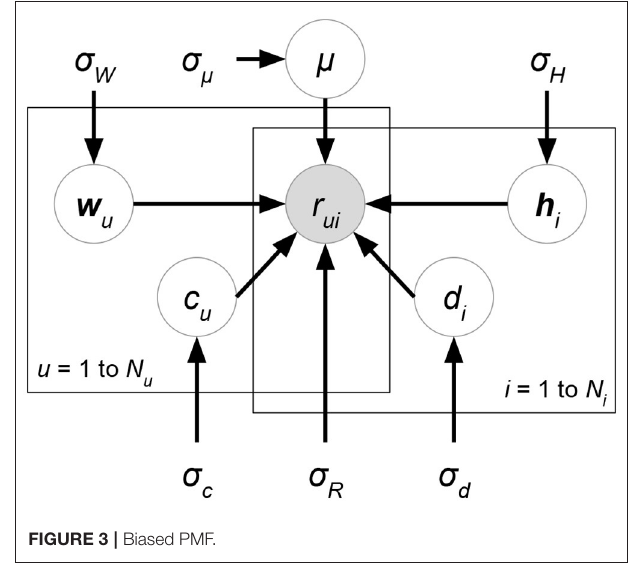
FIGURE 3 | Biased